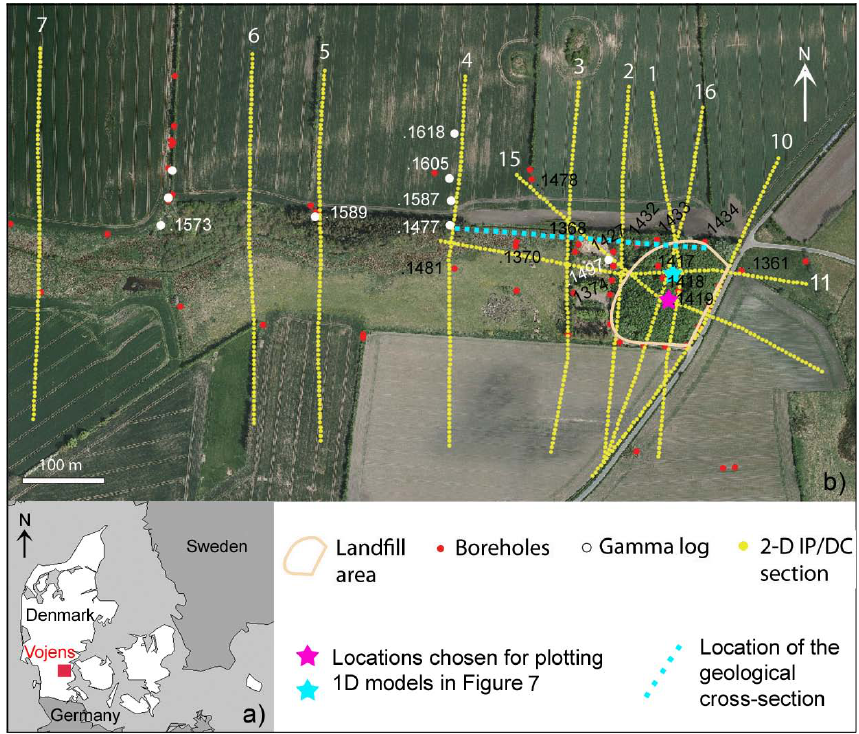
Fig. 1. The survey area. (a) Location of Vojens in the southern part of Denmark. (b) IP/DC sections (yellow dots) performed at the Hørløkke landfill (yellow area). The red dots point out the boreholes; the white dots refer to gamma log locations, and the dashed line fits the geological cross-section. The location of the watershed is about 1.5km east of the map. Copyright Cowi© .